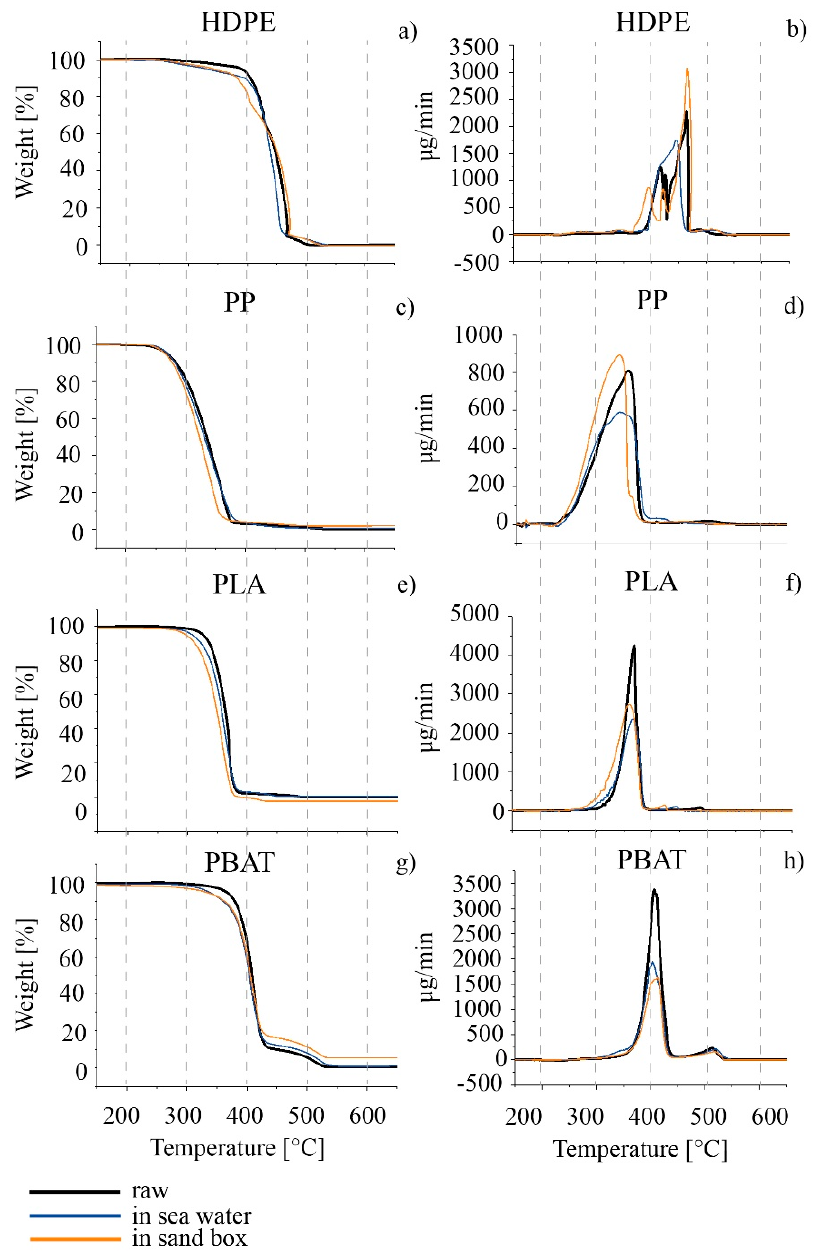
Figure 6. TGA thermograms on the left and the relative DTG on the right of the series HDPE ( a , b ), PP ( c , d ), PLA ( e , f ) and PBAT ( g , h ): raw granules in black; 6 ‐ months ‐ aged in seawater in blue; 6 ‐ months ‐ aged in sandbox in orange. The scale on the abscissa is the same for all the curves.